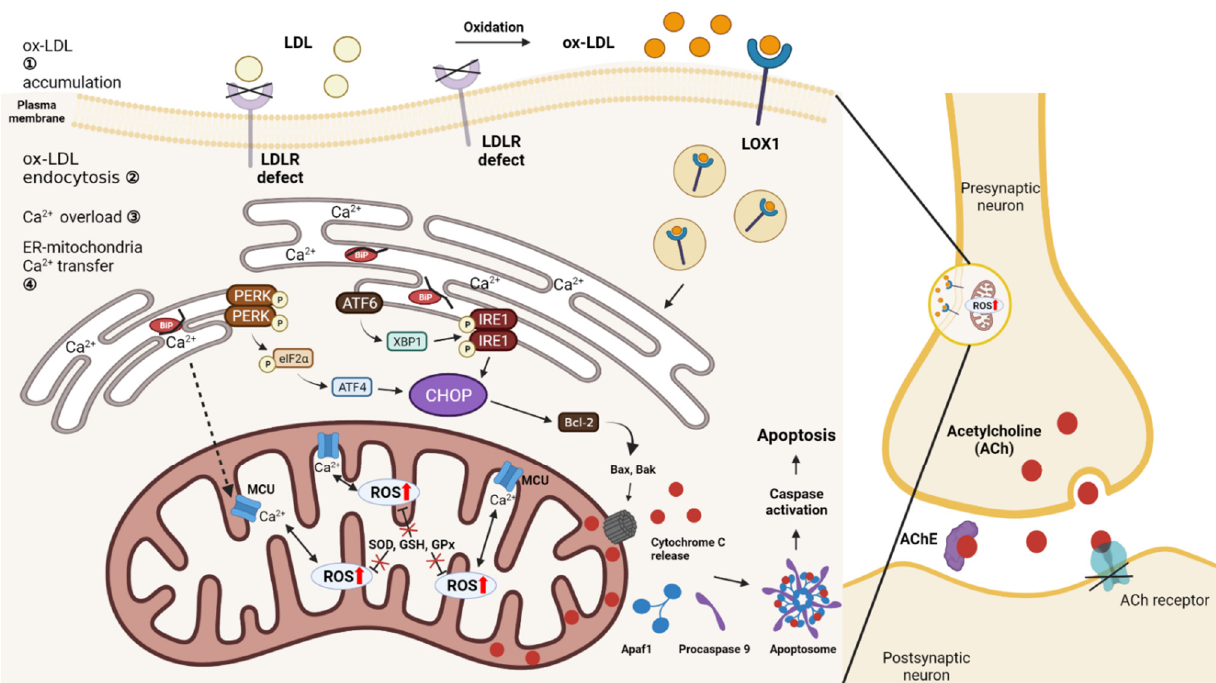
Figure 3. Interaction between ER stress and mitochondria. The process by which ER stress and mi- tochondria interact due to oxLDL accumulation due to LDLr deficiency affects cognitive impairment.